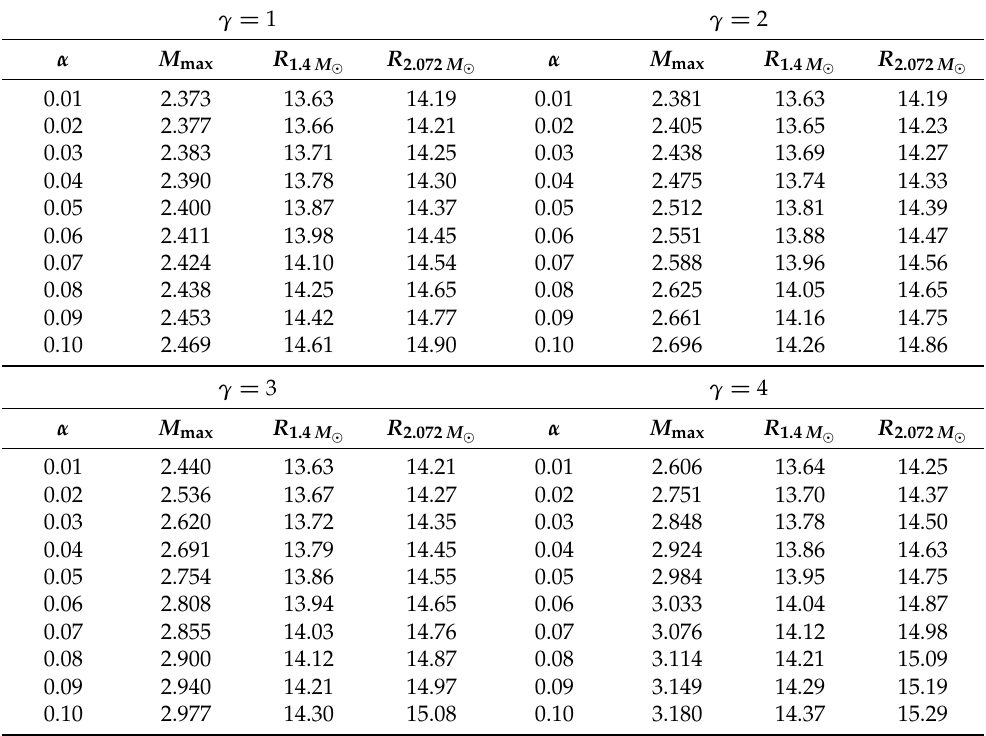
Table 8. Maximum mass ( M max ) in unit of M (cid:12) and radius (km) at M = 1.4 M (cid:12) ( R 1.4 M radius (km) at M = 2.072 M (cid:12) ( R 2.072 M B 0 = 2.5 × 10 18 G).